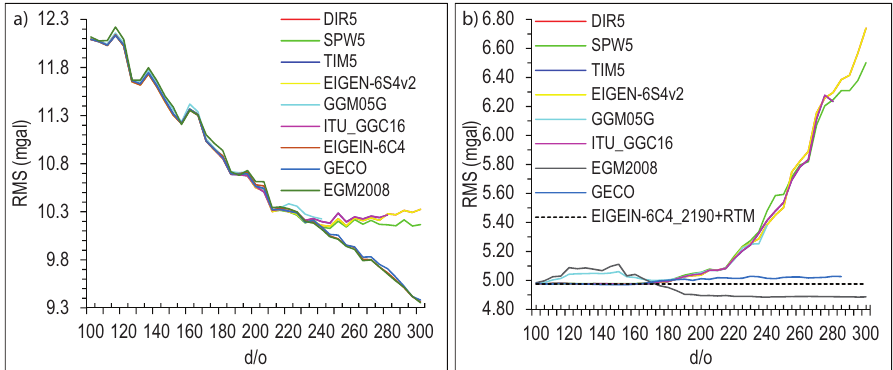
Figure 5. RMS of gravity anomaly differences as function of d/o of spherical harmonics: a – before SEM; b – after